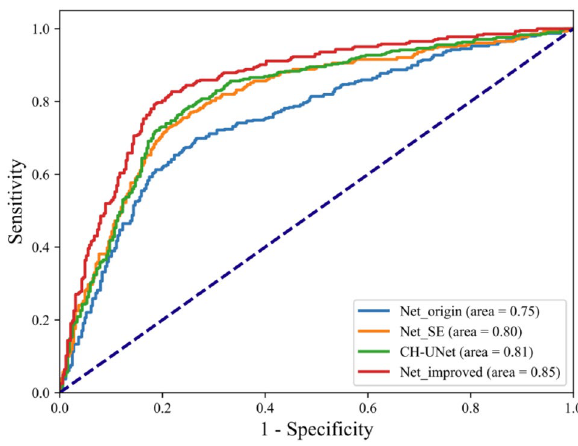
Figure 11. Comparison of ROC curves of four models.